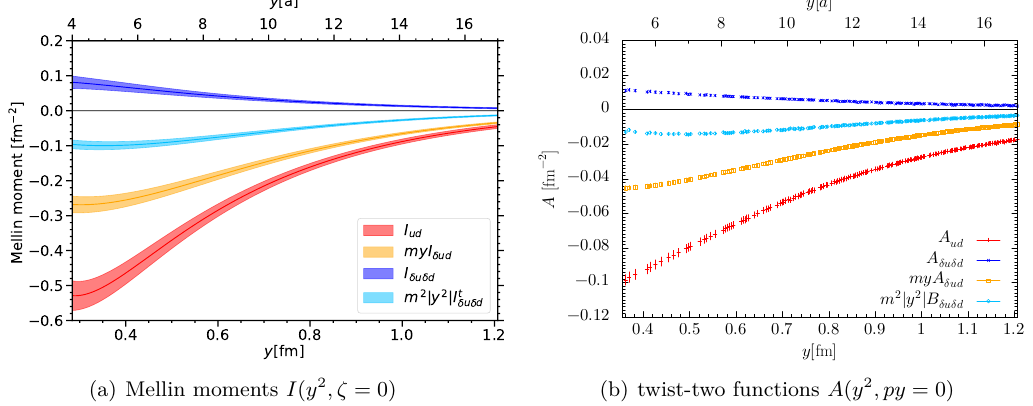
Figure 31 . (a): Mellin moments of DPDs for the flavour combination ud in a π + , reconstructed from our global fit. (b): lattice data for the corresponding twist-two functions at py = 0 . This shows the same data as figure 20(a), but is limited to y ≤ 17 a for ease of comparison. Notice that the minimum y in panels (a) and (b) is slightly